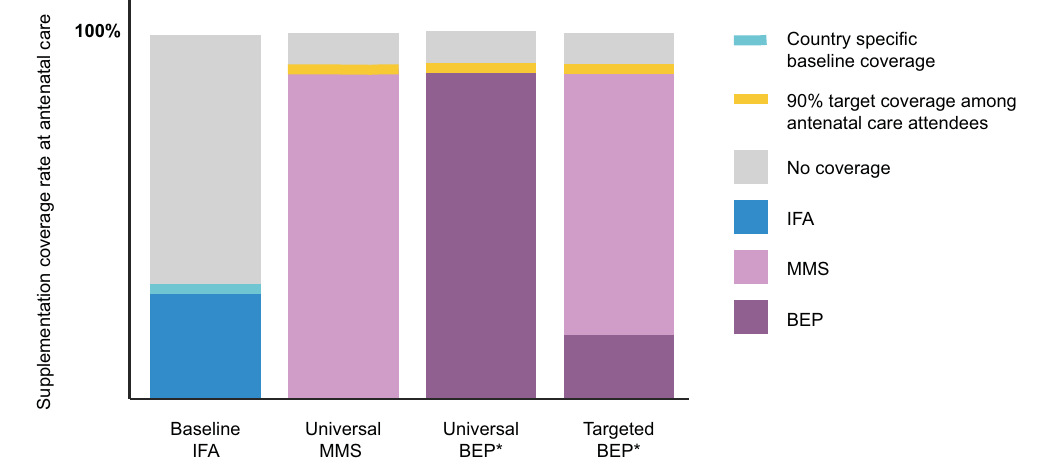
Fig 2. Visual diagram of supplementation coverage among women who attend ANC. Baseline IFA: scenario with country- specific reported coverage of IFA consumption; Universal MMS: scenario where 90% of antenatal attendees receive MMS; Universal BEP: scenario where 90% of antenatal attendees receive BEP; MMS + targeted BEP: scenario where 90% of antenatal attendees receive BEP if undernourished and receive MMS if adequately nourished according to